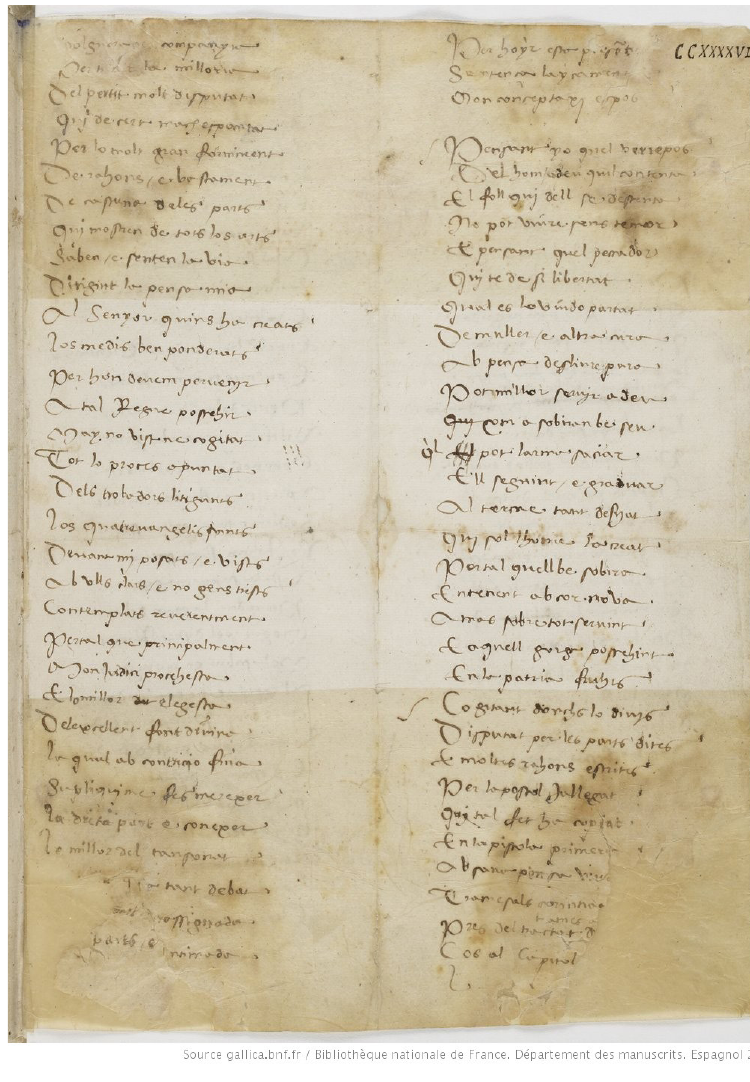
Fig. 2: París, Bibliothèque nationale de France, ms. espagnol 225, fol. ccxxxxvi recto. Font: gallica.bnf.fr / Bibliothèque nationale de